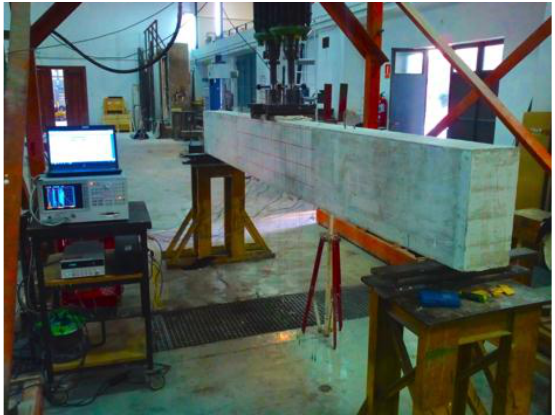
Figure 19. Experimental setup for the reinforced concrete beam externally strengthened with an FRP strip.